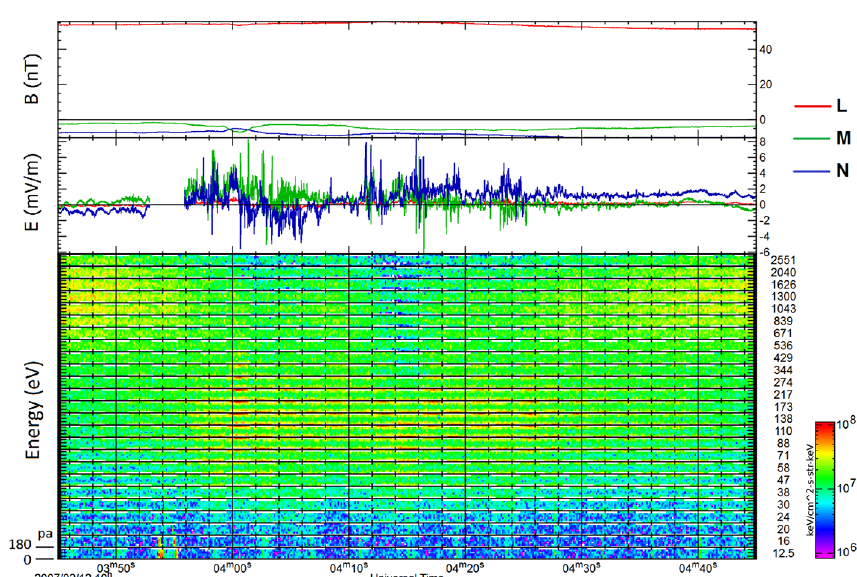
Figure 9. High-time-resolution observations by Cluster 2 from 10:03:45UT to 10:04:45UT. Data are shown in the same format as in Fig. 5. Between 10:04:01UT and 10:04:08UT, the B N component shows a small bipolar signature, which had an offset ∼− 7nT, due to separation of Cluster 2 from reference spacecraft Cluster 3. The electric field reached a relatively higher level and showed more activity, while the energetic electrons disappeared and a population of bidirectional electrons with energy of ∼ 100eV were observed. The B L component reached a slightly higher level throughout the boundary layer indicating that the deflected magnetic field lines were compressed. No entry to magnetosheath is observed for whole time interval. (See Sect. 4.4.3 for